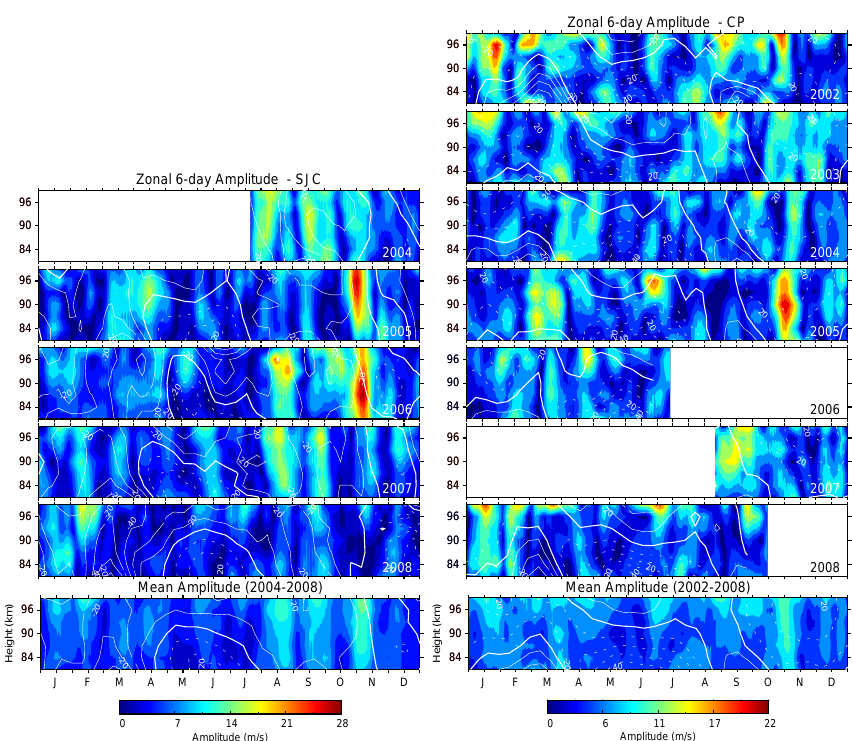
Figure 7. The time-height cross section of the 6–7 day oscillation amplitudes and composite-year 6–7 day amplitudes at Cariri (left hand plots) and over C. Paulista (right hand plots) for zonal component, for the years 2004 to 2008 and 2002 to 2008, respectively. Monthly mean eastward (dotted) and westward (solid) winds also are plotted as open white contours.